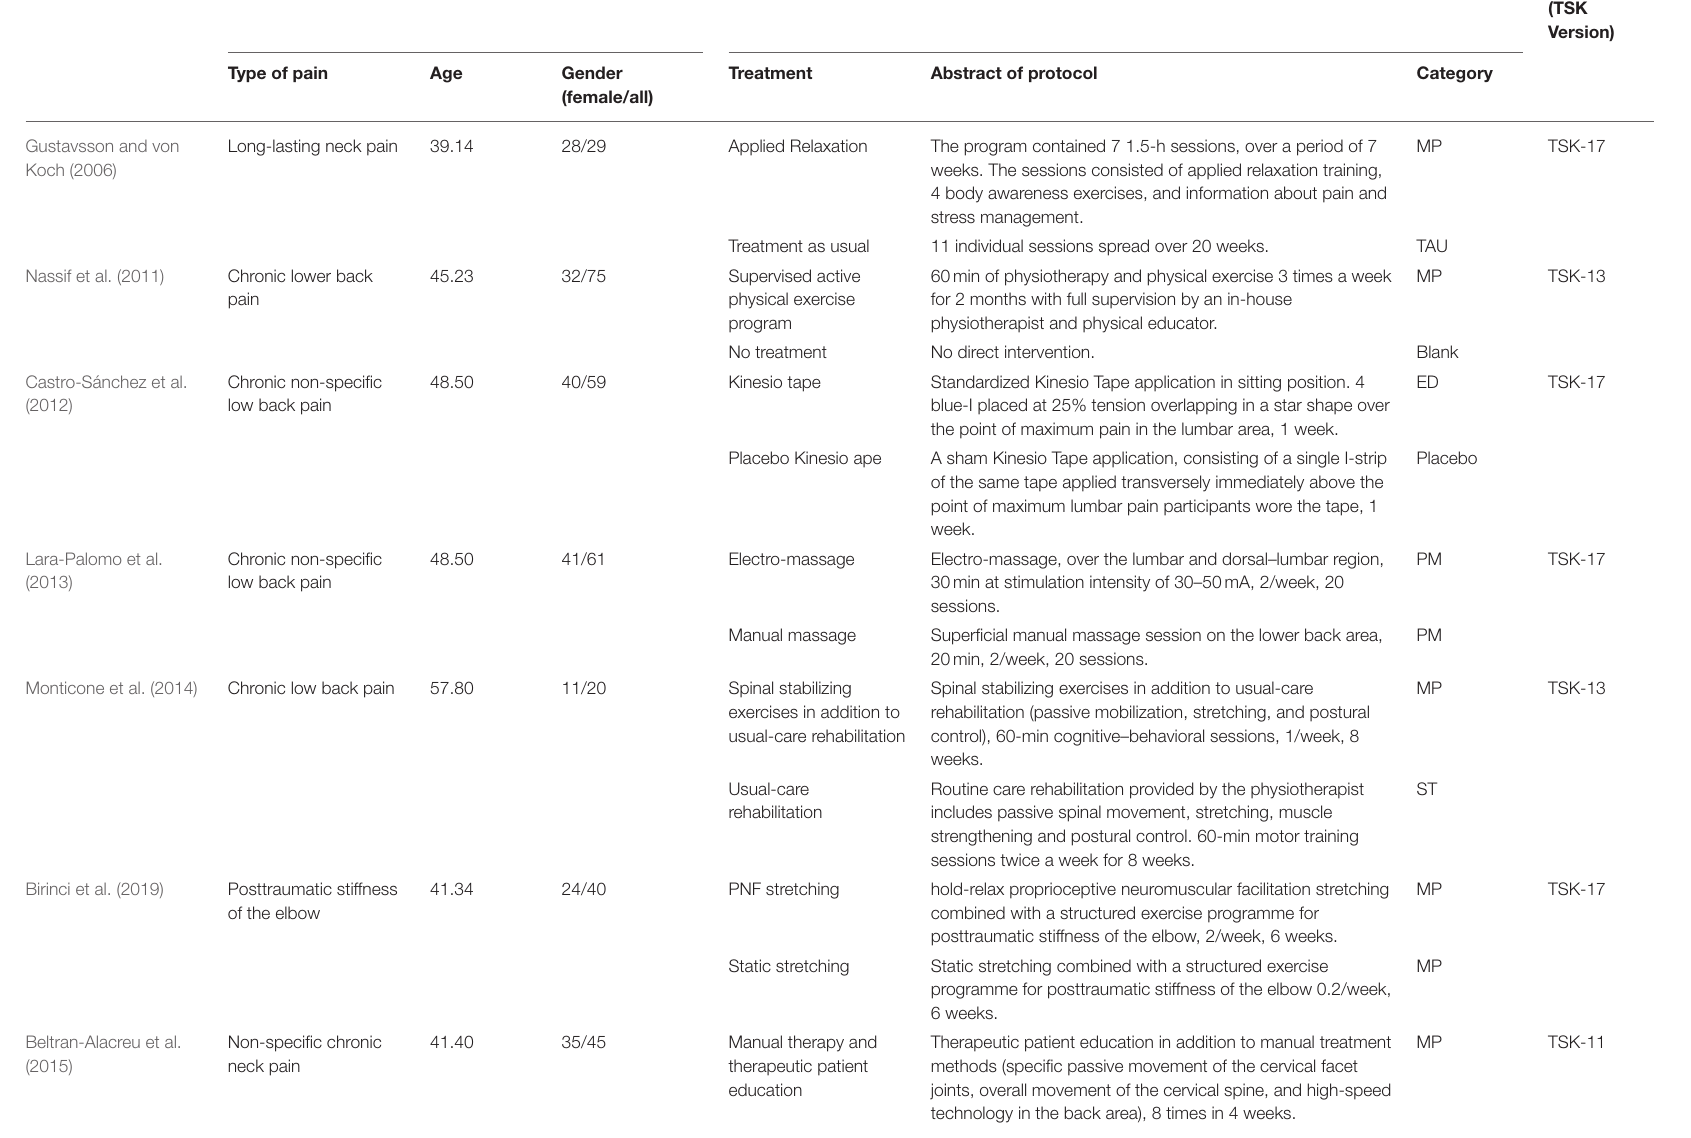
TABLE 1 | Detailed information of included